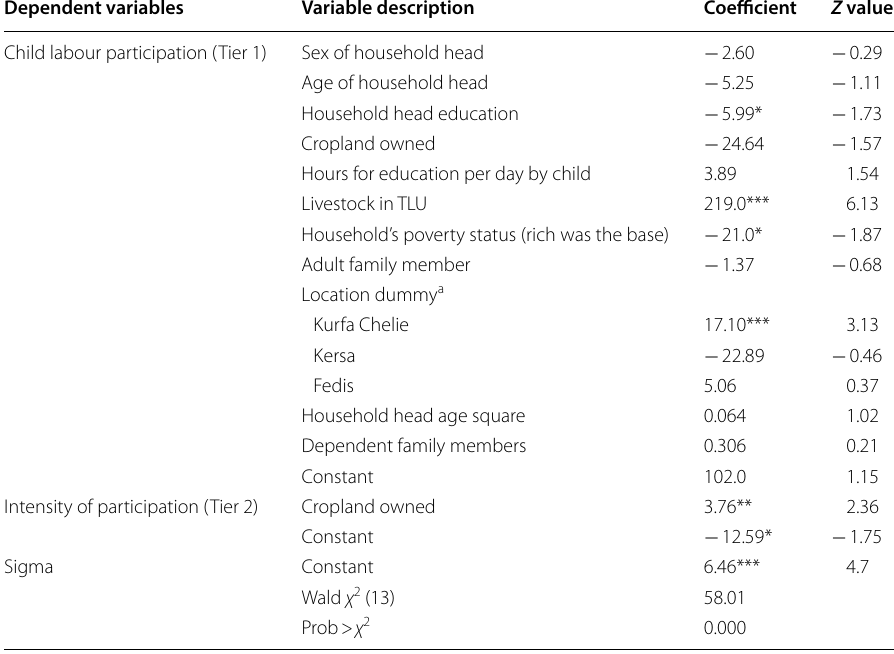
***, **, and * 1%, 5% and 10% level of significance, respectively a Melka Bello district was the base in constructing dummy